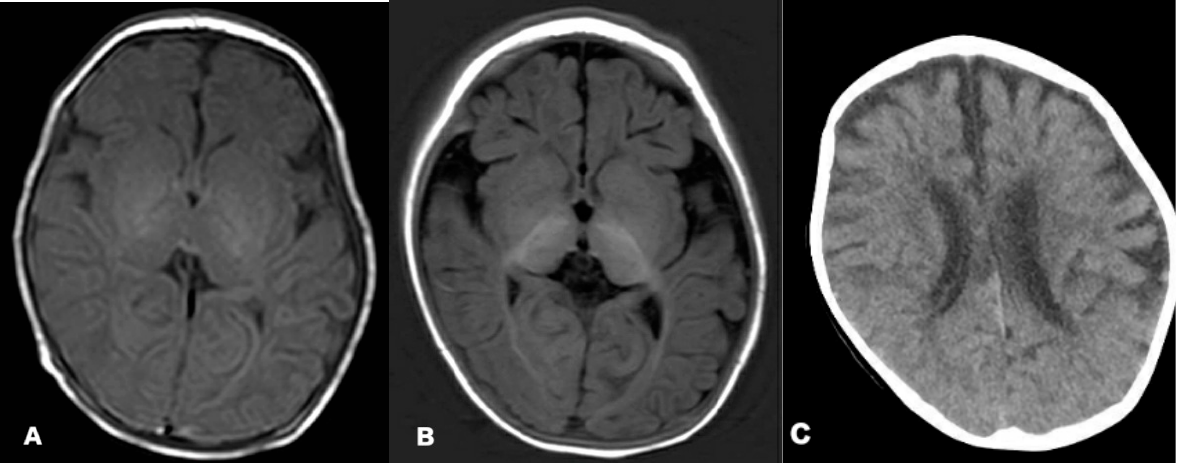
Figure 1. Brain MRI of the patient at the ages of 1 month ( A ) and 6 months ( B ). Brain CT of the patient at the age of 2 years and 10 months ( C ). Axial T1-weighted images suggested decreased periventricular white matter on both sides ( A , B ). Brain CT showed atrophic changes in both cerebral hemispheres ( C ).